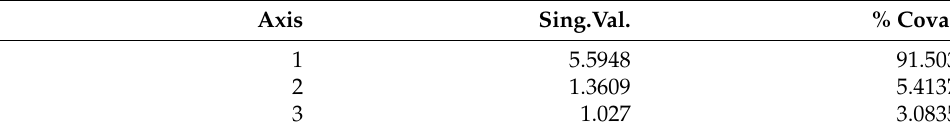
Table 3. Linear bi-components for “phenotype-genotype” co-variation. Axis Sing.Val. % Covar